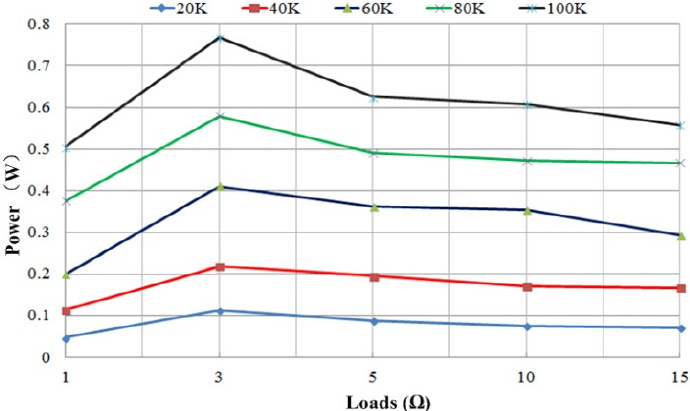
Figure 5. Measurement results of the output voltage versus different loads of TEG module in five temperature difference situations.